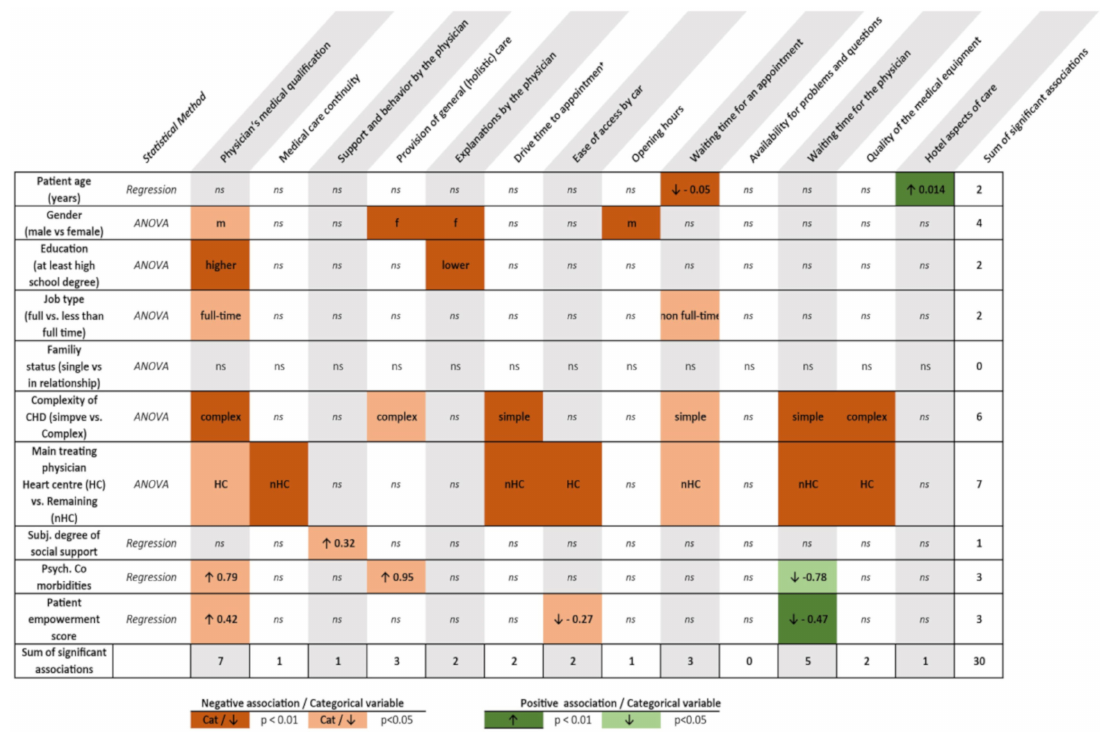
Figure 5. Differences between patients’ preferences and subject characteristics; ns = not